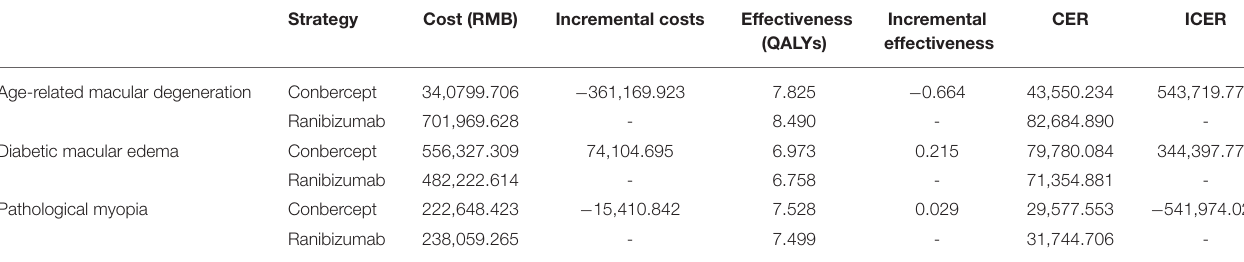
TABLE 7 | The cost-effectiveness analyses of conbercept and ranibizumab in RCT scenario.